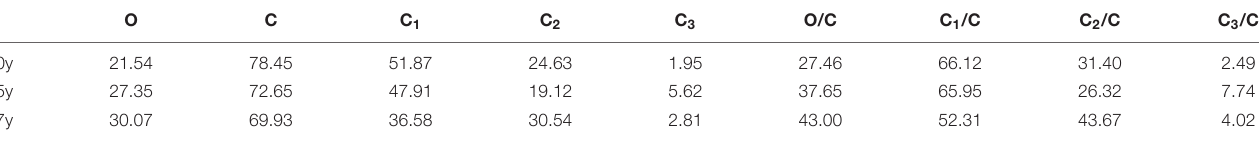
TABLE 2 | Elemental composition of S. psammophila sand barrier